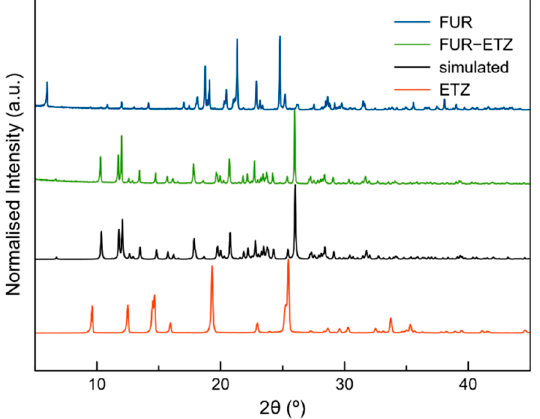
Figure 1. PXRD patterns of the new phase FUR–ETZ obtained by liquid-assisted grinding (LAG) with methanol (MET) solvent, the simulated pattern from crystal structure and the corresponding reactants.